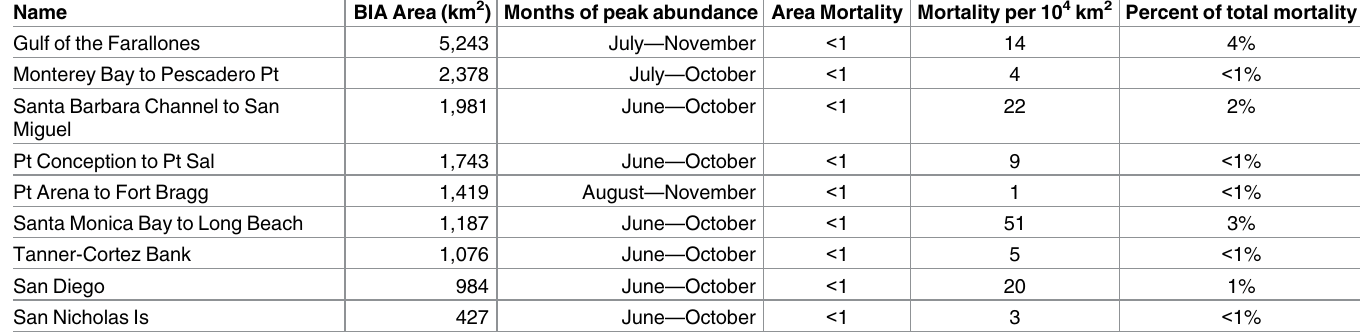
Table 4. Statistics of blue whale strike mortality within the Biologically Important Areas (BIAs) defined in Calambokidis et al. 2015. Total mortality, mortality per 100,000km 2 and percent of total study area mortality are reportedfor each BIA.